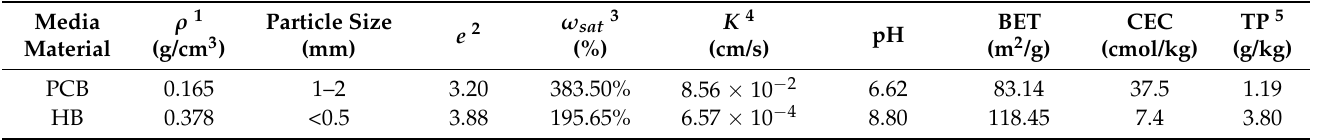
Table 1. Physicochemical properties of PCB and